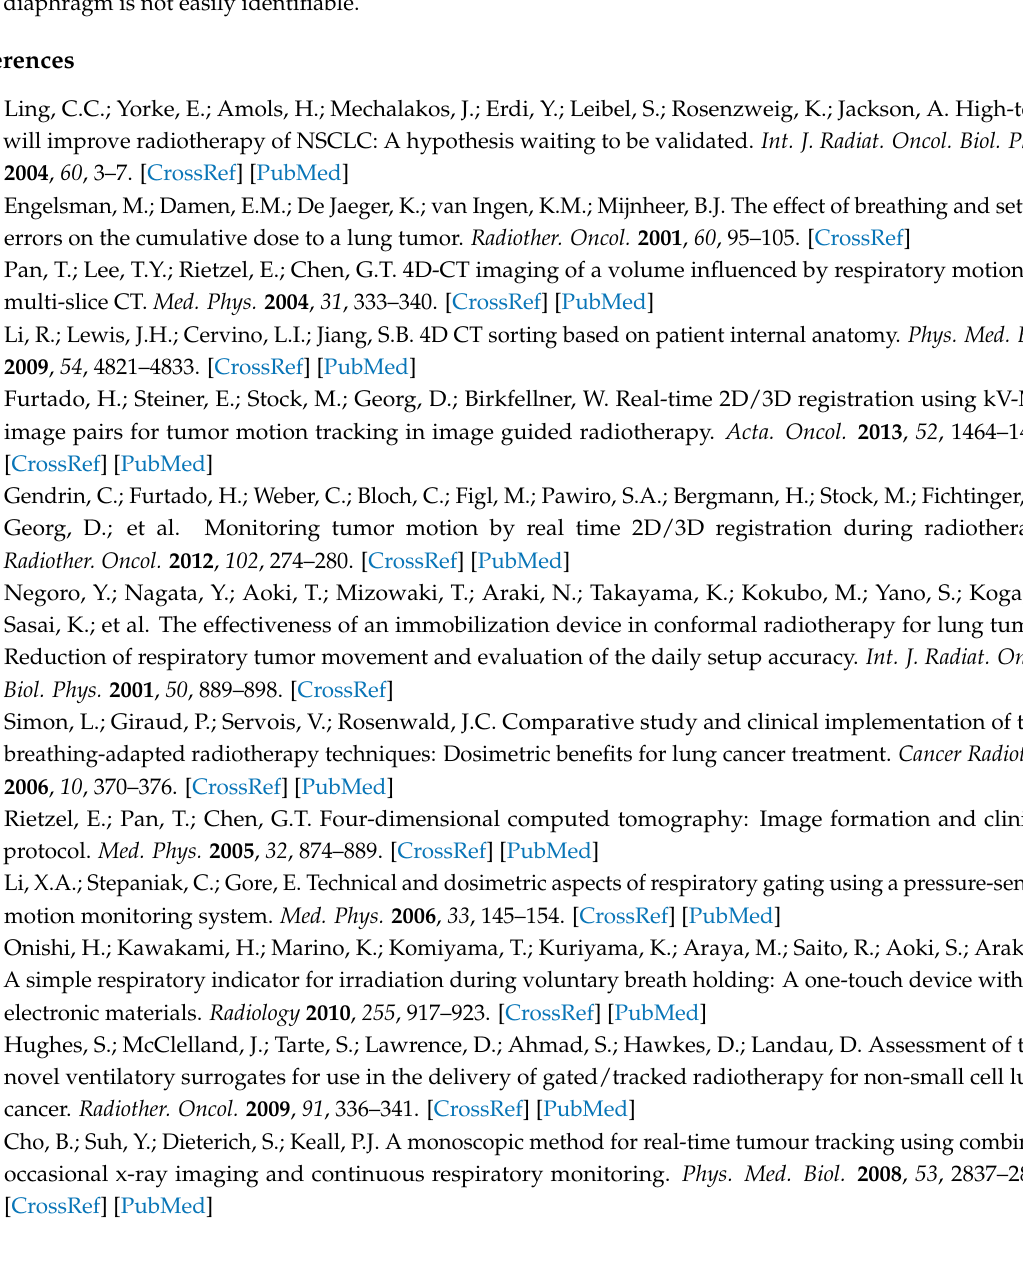
Figure A2. Representative projections of the patients in a bad condition in which the shape of the diaphragm is not easily identifiable.